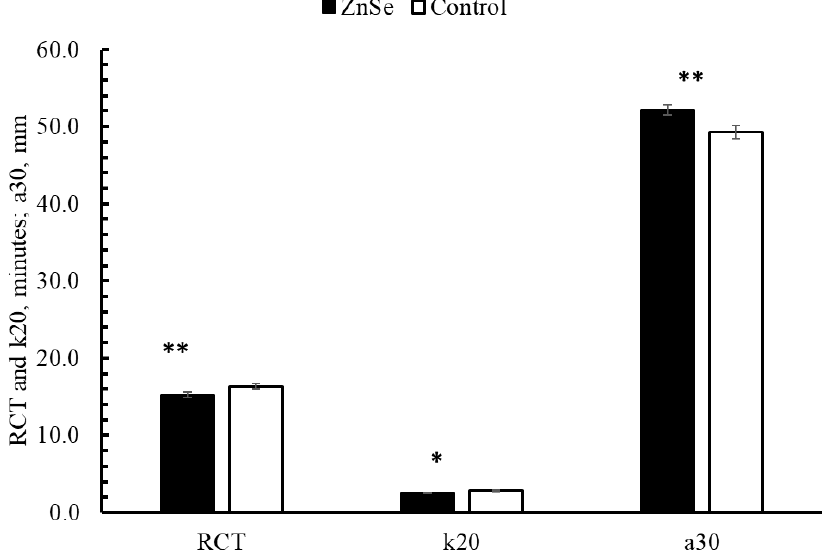
Figure 3. Technological characteristics of milk in the two groups. RCT: rennet coagulation time, min; k 20 : curd firming time, min; a 30 : curd firmness, mm; * p < 0.05, ** p < 0.01. Milk total antioxidant activity (TAA) was not affected by treatment. TAA was 408.15 ± 24.18 vs. 432.97 ± 25.64 µmol of neutralised HClO/mL for the ZnSe group and control group, respectively (Figure 4).